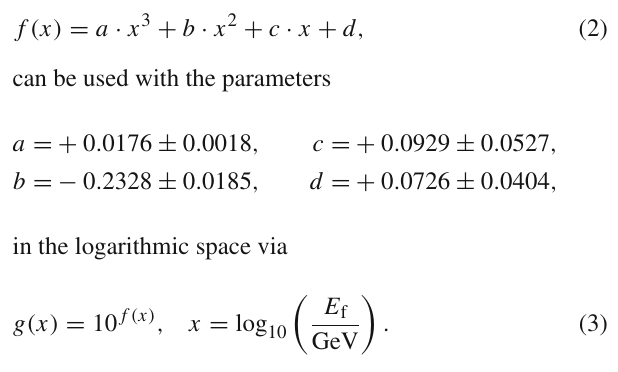
deflectionsandMolièrescattering(MSM),theorangepointspresentthe mean of the simulation taking into account only Molière scattering. The uncertainties on the x -axis result due to the measured bin widths. The y - uncertainties are the standard deviations for PROPOSAL and the Pois- √ N for Akimenko, with N as number of counts. More son errors with large deflections are simulated by PROPOSAL. Considering stochastic deflections has no significant